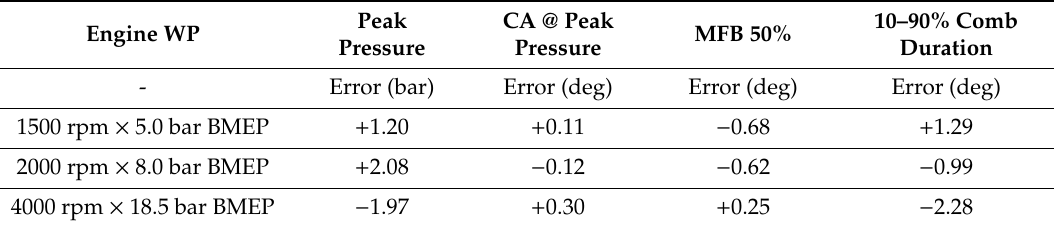
Figure 11. Peak pressure ( top–left ), Crank Angle at Peak Pressure ( top–right ), 10–90% Combustion Duration ( bottom–right ), and MFB50% ( bottom–left ) comparison between experiments (black square) and simulation results (red circle). Table 5. Absolute errors of the simulation results with respect to the experimental data for the main combustion parameters presented in Figure 11.